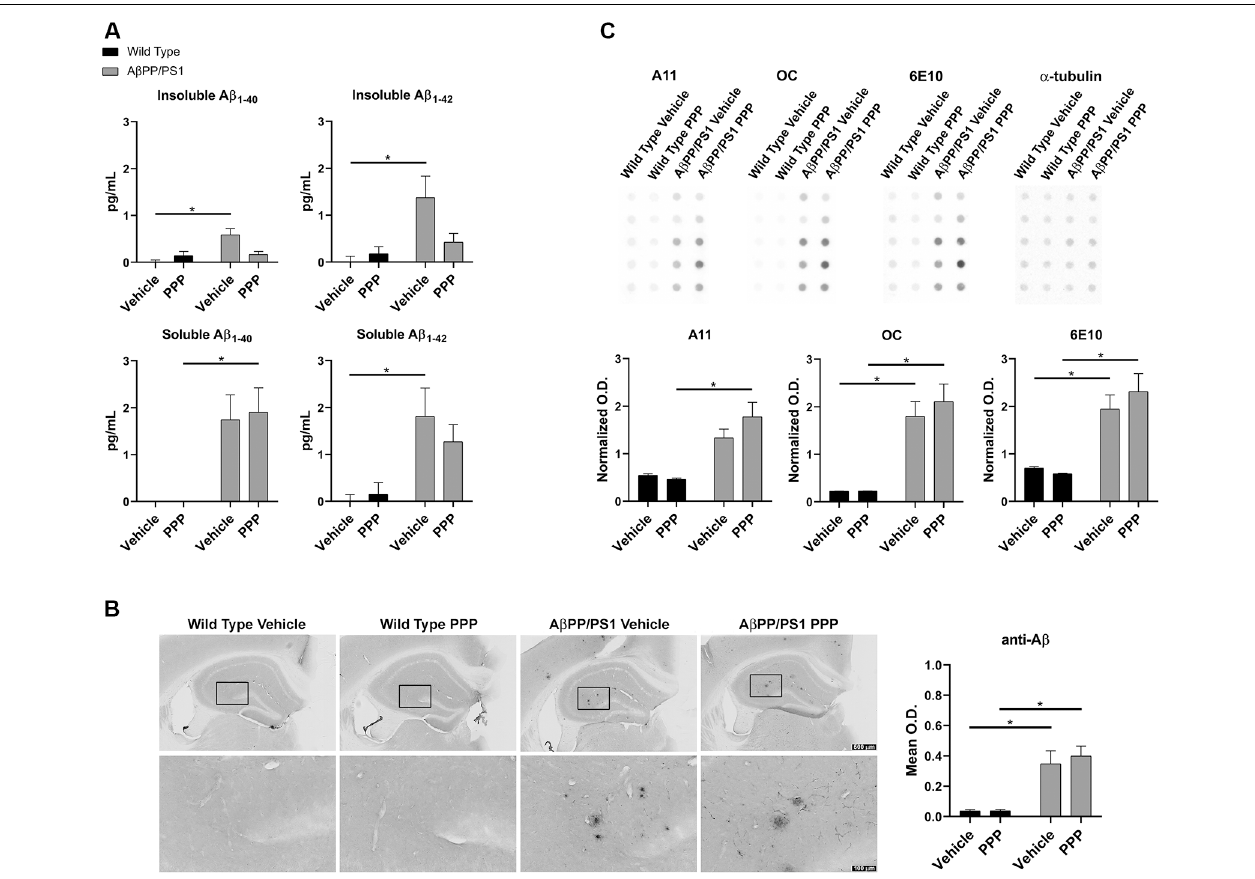
FIGURE 1 | Insulin-like growth factor-1 receptor (IGF-1R) inhibitor treatment attenuated A β levels in A β PP/PS1 mice. (A) Temporal cortex lysates collected from male wild type (WT) and A β PP/PS1 mice, treated with vehicle (DMSO) or picropodophyllin (PPP, 1 mg/kg) for 7 days, were used to perform ELISAs for insoluble and soluble A β 1–40 / 42 . Data are mean ± SEM, * p < 0.05 ( n = 7–9 animals). Two-way ANOVA indicate insoluble A β 1–40 F (1,24) = 9.576 and p (interaction) = 0.0050; soluble A β 1–40 F (1,23) = 0.4255 and p (interaction) = 0.5207; insoluble A β 1–42 F (1,26) = 4.896 and p (interaction) = 0.0359; soluble A β 1–42 F (1,24) = 0.8341 and p (interaction) = 0.3702. The errors from comparisons of several pairs of means in the experiment were adjusted using Tukey’s multiple comparison tests. (B) Immunohistochemistry (IHC) was performed on both WT and A β PP/PS1 mouse brains using anti-A β (4G8) antibody and the mean optical density of hippocampal staining was measured. Data are mean O.D. ± SEM, * p < 0.05 ( n = 6 animals/condition). Two-way ANOVA indicate A β IHC F (1,20) = 0.2204 and p (interaction) = 0.6438. The errors from comparisons of several pairs of means in the experiment were adjusted using Tukey’s multiple comparison tests. Representative hippocampal images are shown. (C) Hippocampal lysates from vehicle and PPP treated WT and A β PP/PS1 mice were dot blotted to quantify total A β (6E10), oligomeric peptide (A11), and fibrillar peptide (OC) changes. Data are mean O.D. ± SEM, * p < 0.05 ( n = 5 animals). Two-way ANOVA indicate A11 dot blot F (1,16) = 2.147 and p (interaction) = 0.1623; OC dot blot F (1,16) = 0.4042 and p (interaction) = 0.5339; 6E10 dot blot F (1,16) = 1.032 and p (interaction) = 0.3249. The errors from comparisons of several pairs of means in the experiment were adjusted using Tukey’s multiple comparison